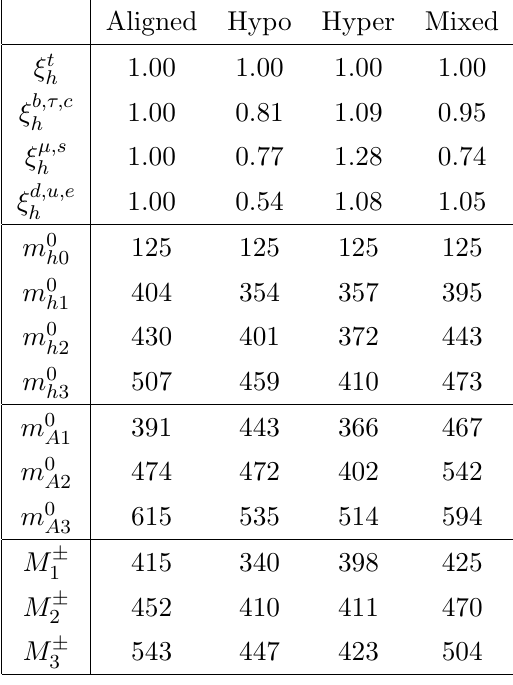
Table 3 . Outputs for each of the four numerical benchmark scenarios. Scalar masses are given in